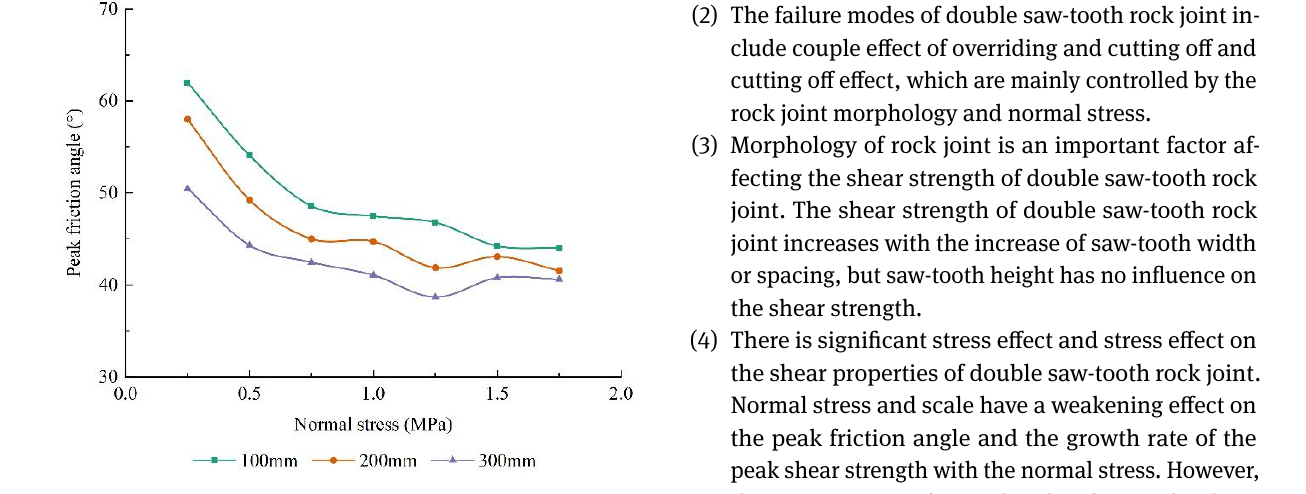
Figure 19: Relationship between peak friction angle and scale under different normal